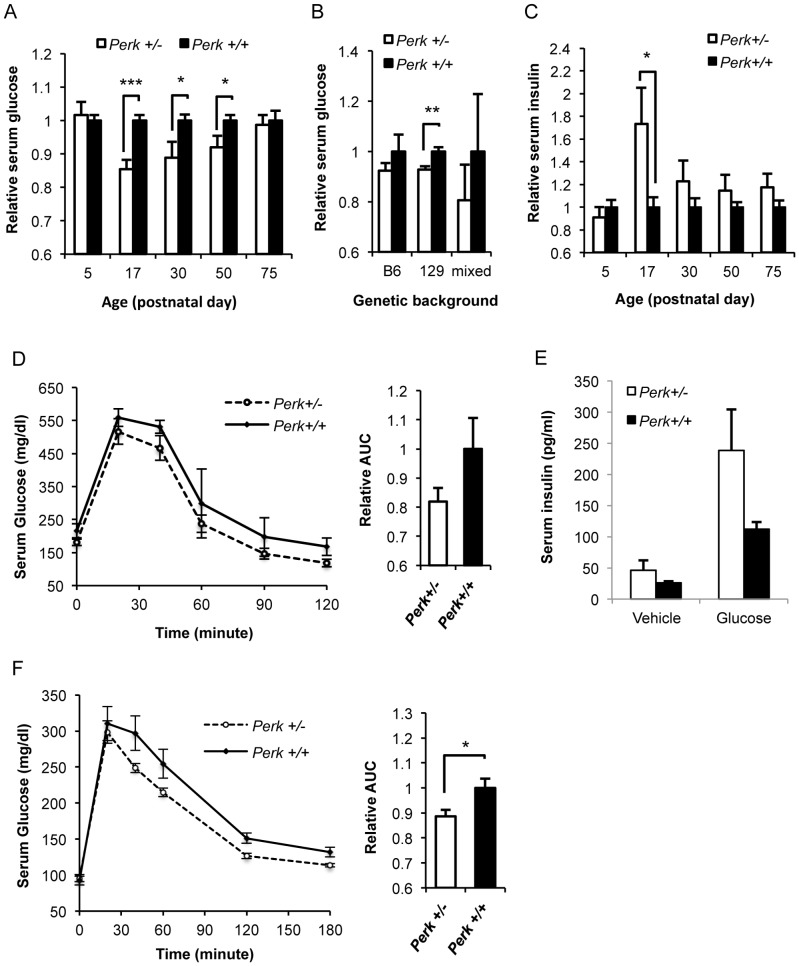
Glucose and insulin homeostasis were impacted by modulation of Perk during development.A. Random fed serum glucose of Perk+/− mice relative to Perk+/+ during postnatal development. Age of mice was shown as indicated, except that mice belonging to P75 group were from P70 to P90. Mice are in C57BL/6 background. Shown are means ± SEM (n for Perk +/−, Perk+/+  =  18, 16 (P5); 16, 17 (P17); 13, 11 (P30); 12, 16 (P50); 17, 18 (P75). *P<0.05, ***P<0.001). B. Random fed serum glucose of Perk+/− mice relative to Perk+/+ at 9–12 month. Mice are in C57BL/6, 129 SvEvTac or mixed background. Shown are means ± SEM. (n for Perk +/−, Perk+/+  =  4, 5 (B6); 23, 20 (129); 5, 3. **P<0.01). C. Random fed serum insulin of Perk+/− mice relative to Perk+/+ during postnatal development. Age of mice was shown as indicated, except that mice belonging to P75 group were from P70 to P90. Shown are means ± SEM (n for Perk +/−, Perk+/+  =  28, 28 (P5); 19, 17 (P17); 25, 18 (P30); 56, 75 (P50); 29, 32 (P75). *P<0.05). D. Glucose tolerance test of P17 mice after 4 hour fasting. Serum glucose was measured at various time points after glucose injection as indicated above. GTT traces are shown as means ± SEM of each time point and quantified by calculating area under the curve (AUC) in relative to Perk+/+ (n for Perk +/−, Perk+/+  = 5, 4). E. Serum insulin collected in P17 mice 30 minutes after injection with glucose or vehicle (n for Perk +/−, Perk+/+  = 5, 4. P = 0.16 for stimulated insulin levels). F. Glucose tolerance test of P50 mice after 16 hour fasting. Experiment and analysis were as in 2D (n for Perk +/−, Perk+/+  = 18, 18, *P<0.05).